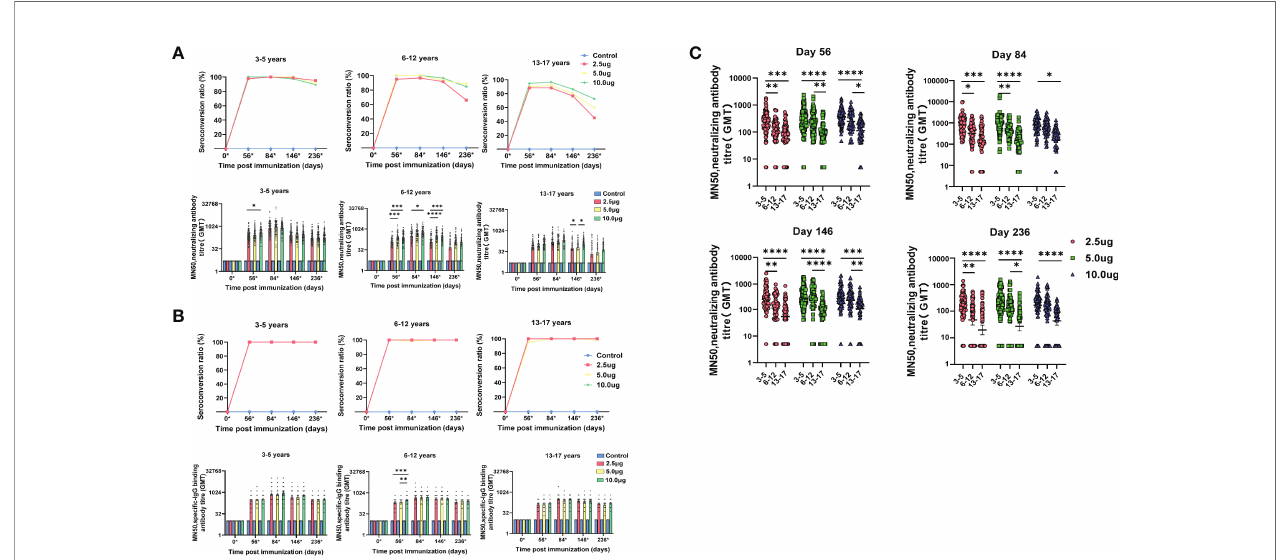
FIGURE 2 | Antibody responses at different time points among different age cohorts in the phase 1/2 trial. (A) Seroconversion rates and geometric mean titers (GMTs) of neutralizing antibody to SARS-CoV-2 at different time points among different groups. (B) Seroconversion rates and GMTs of speci fi c-IgG binding antibody to SARS- CoV-2 at different time points among different groups. (C) Titers of neutralizing antibody to SARS-CoV-2 were compared among different age cohorts at different time points after vaccination. Circles show the individual antibody titers and bars represent the geometric mean titers of antibodies. Error bars refer to the 95% CI. Seroconversion was de fi ned as an increase of at least four-times post-vaccination titer from baseline. *, P < 0.05; **, P < 0.01; ***, P < 0.001; ****, P <